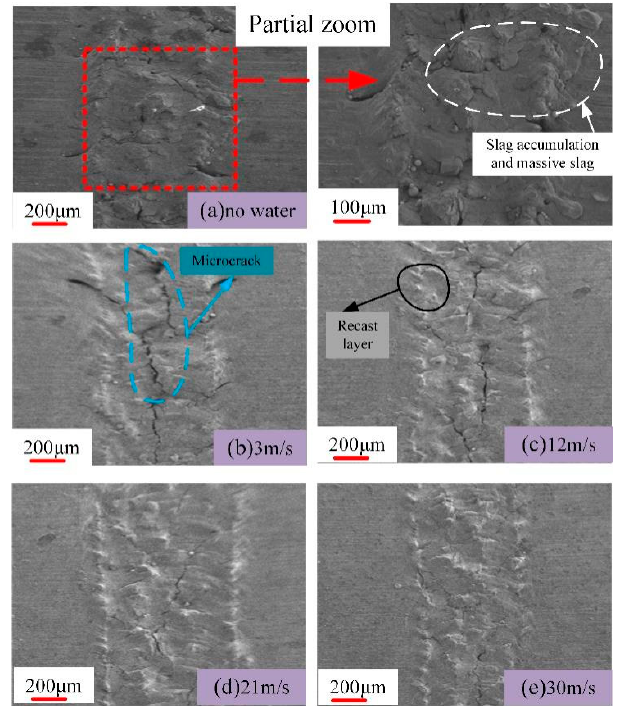
Figure 5. Groove micro-morphology. Figure 5. Groove